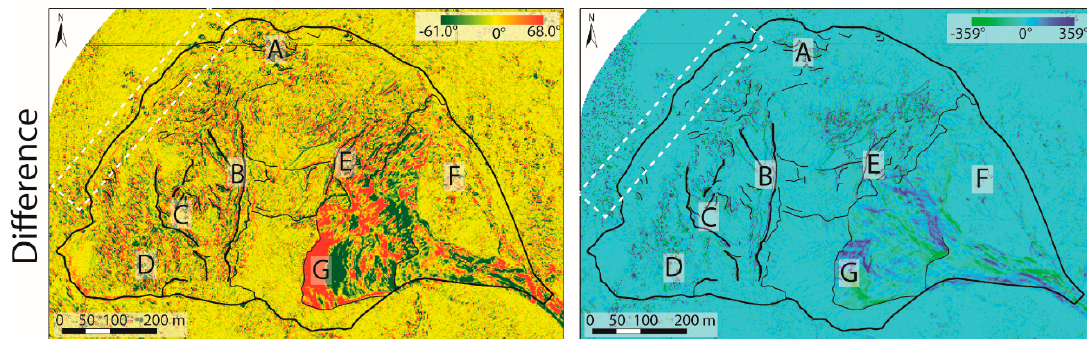
Figure 5. Aspect and slope maps of the pre- and post-DEMs and maps of the post- and pre-differences in those parameters. A–G localize the areas affected by the main morphological changes. The black lines highlight forms that are related to gravity (e.g., minor crowns, lithostructural and morphological scarps, counterscarps, crests, and trenches). The white dashed boxes in the slope difference maps highlight the presence of an anomaly associable with the newly activated sliding surface. The same box in the aspect differences map underlines the absence of that anomaly.